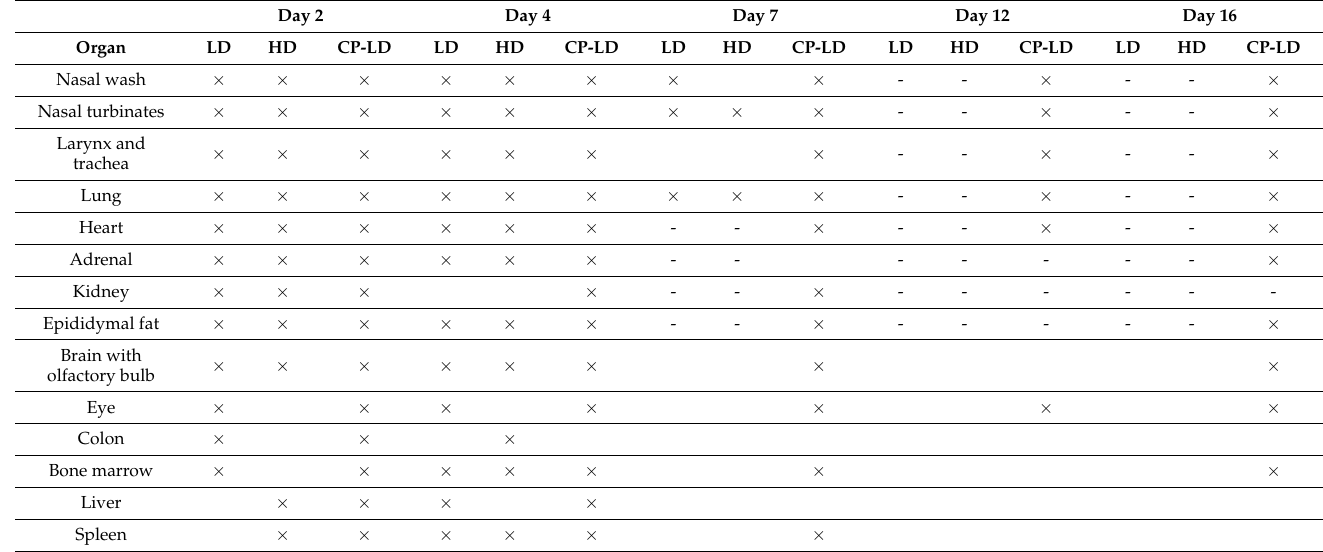
Table 1. The detectable SARS-CoV-2 in infected hamster organs at different time